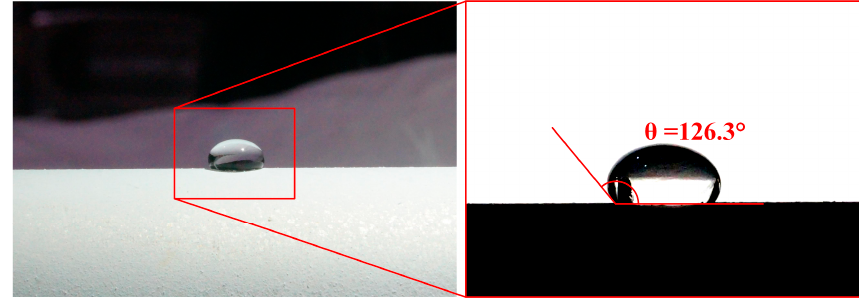
Figure 7. Hydrophobic surface contact angle measurement.